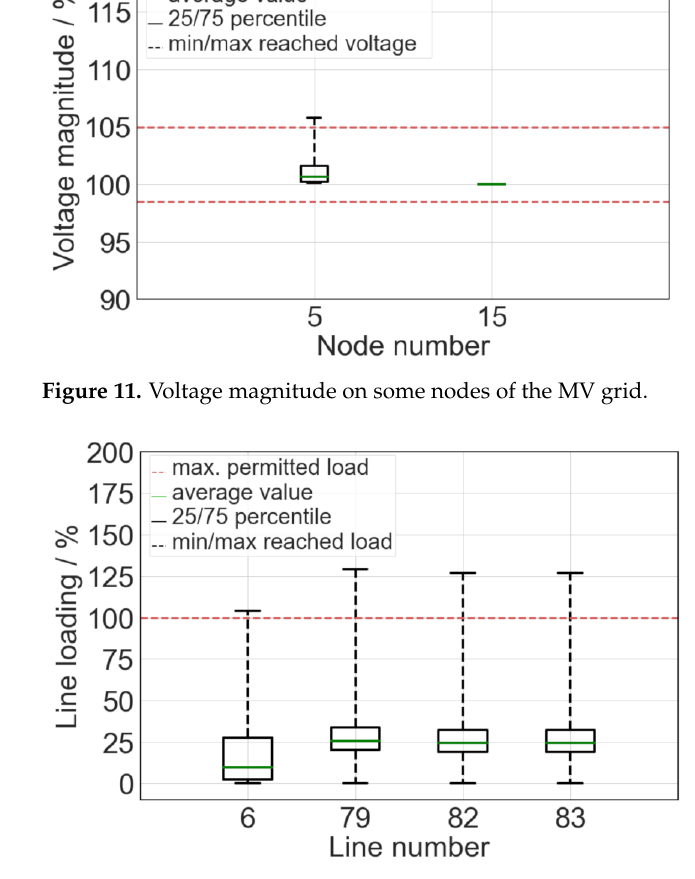
Figure 12. Line loading on the overloaded lines of the MV